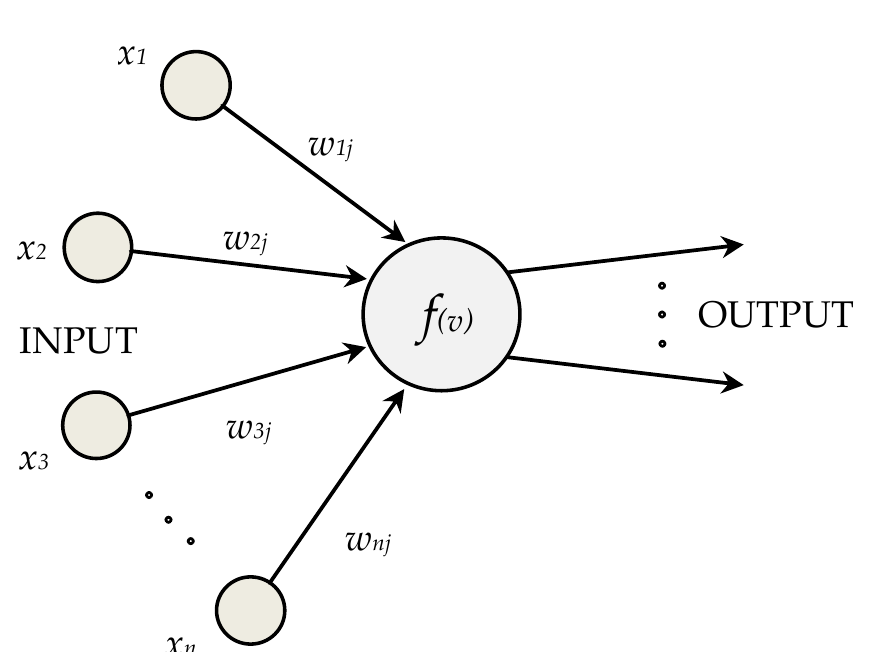
Figure 3. Single artificial neuron representation.